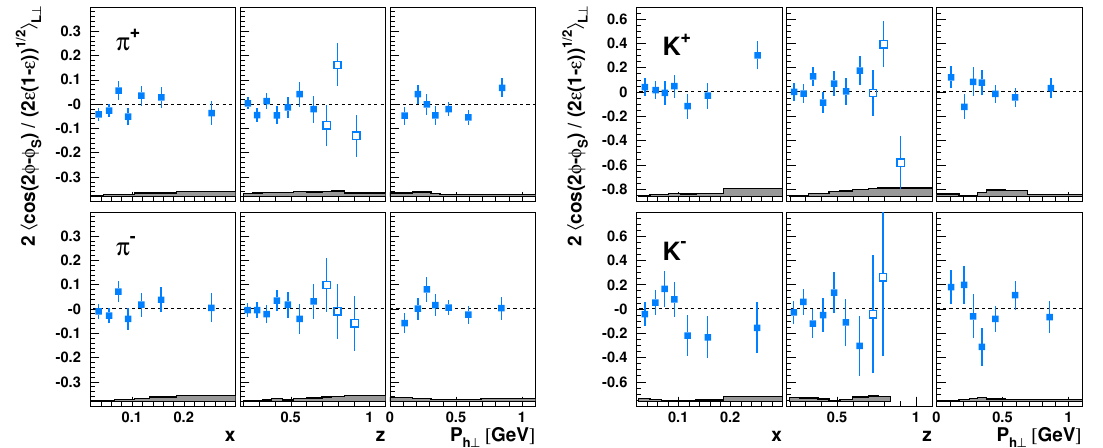
p Figure 29 . The 2 h cos(2 φ − φ S ) / 2 (cid:15) (1 − (cid:15) ) i h amplitudes for charged mesons (left: pions; right: L ⊥ kaons) presented either in bins of x , z , or P h ⊥ . Data at large values of z , marked by open points in the z projection, are not included in the other projections. Systematic uncertainties are given as bands, not including the additional scale uncertainty of 8.0% due to the precision of the target- polarization